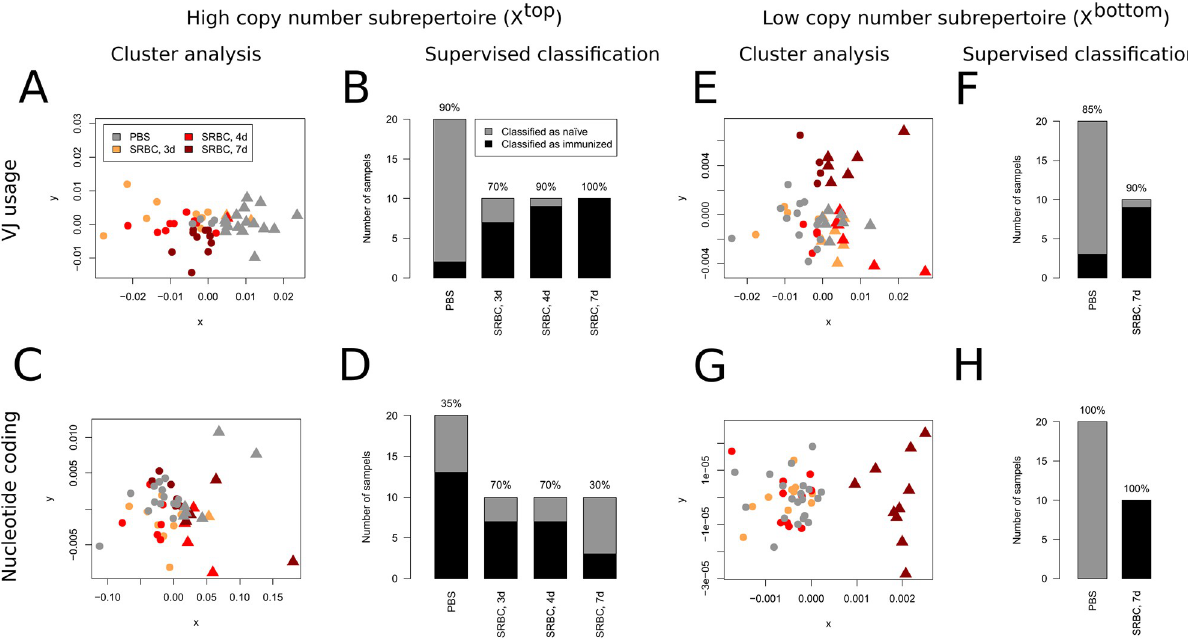
Fig 3. Sub-repertoires can reliable be classified in view of the immunization status depending on the classification criterion. (A)-(D) The high copy number sub-repertoire X top was defined as clonotypes with copy number > 64. (A) A dissimilarity matrix was calculated based on VJ segment usage (see Material and methods) by which these sub-repertoires were divided into two clusters (immunized vs. control) using the K-medoid algorithm and the result visualized via metric multidimensional scaling with dissimilarities approximated by distances of points in the scatterplot and clusters defined by the algorithm displayed as circles and triangles, respectively. (B) The same dissimilarity matrix was used for a supervised classification that in total assigned 44 of the 50 data sets correctly. The number on top of each bar denotes the percentage of correctly classified samples for each of the 4 experimental groups. (C)-(D) The X top sub-repertoire data were classified based on the variability of clonotype nucleotide coding, which fails to distinguish any of the experimental groups from the others. In total, 22 of the 50 data sets were classified correctly which does not significantly outstrip random labeling ( p = 0.377). (E)-(H) The low copy number sub-repertoire X bottom was defined as clonotypes with copy number � 4 and subjected to the same classification approaches as the X top sub-repertoires, with the exception that for supervised classification the control data sets were compared to immunized samples of the SRBC group 7 days (d) after immunization only. Although the VJ usage as criterion did not result in obvious clustering (E) the supervised approach (F) significantly outstripped random classification ( p < 2 � 10 − 4 ). The nucleotide coding criterion led to a well separated cluster formed by the 7d SRBC group (G) that could be classified with perfect accuracy (H). In contrast, the X bottom sub-repertoire of animals 3d and 4d after immunization were indistinguishable from corresponding sub-repertoires of control